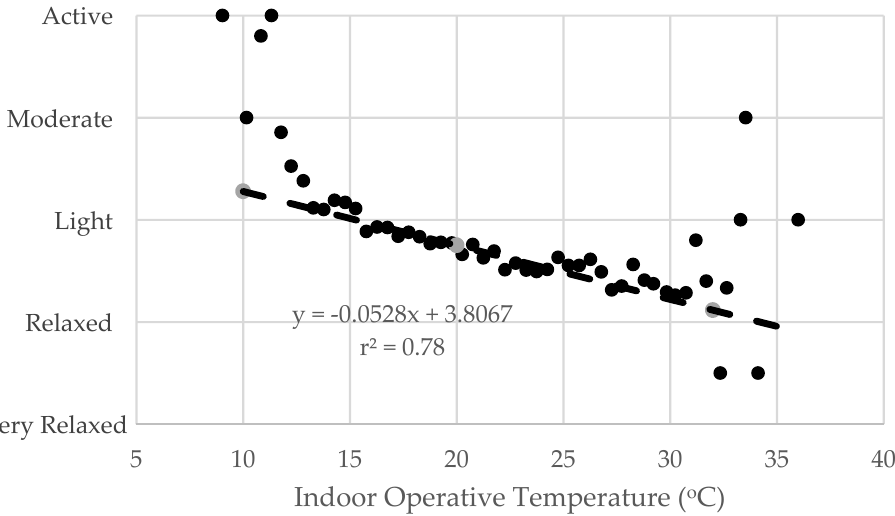
Figure 8. Activity level, as reported by the participants, vs. indoor operative temperature.